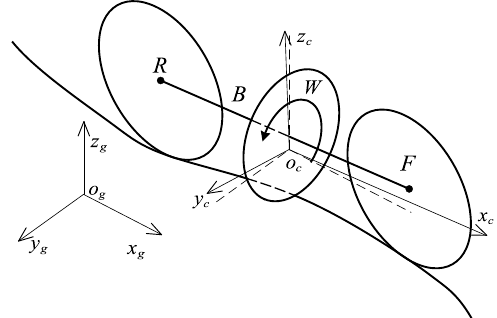
Figure 2. RWBR on a curved pavement.